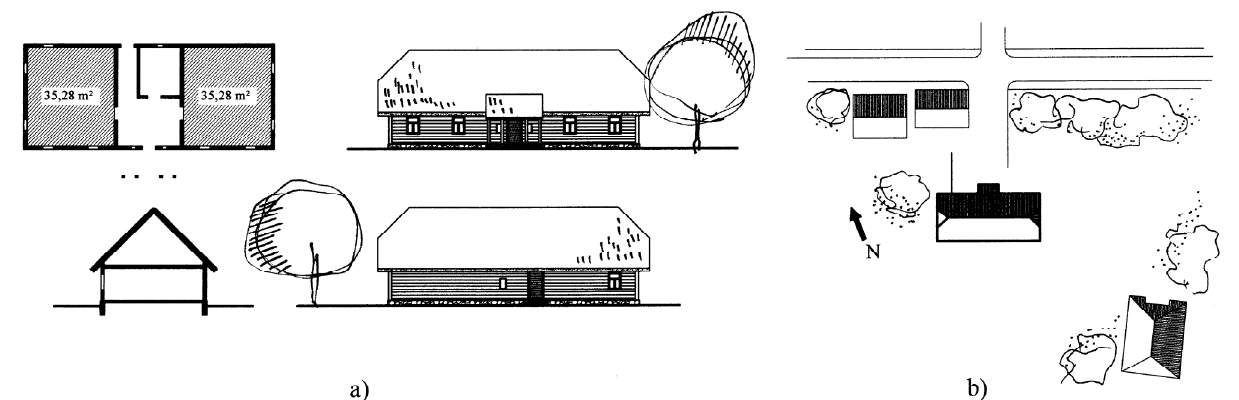
Fig. 1. Vernacular building from Aukštaitija region, Lithuania (Šešelgis et al. 1965): a) architecture; b) situation